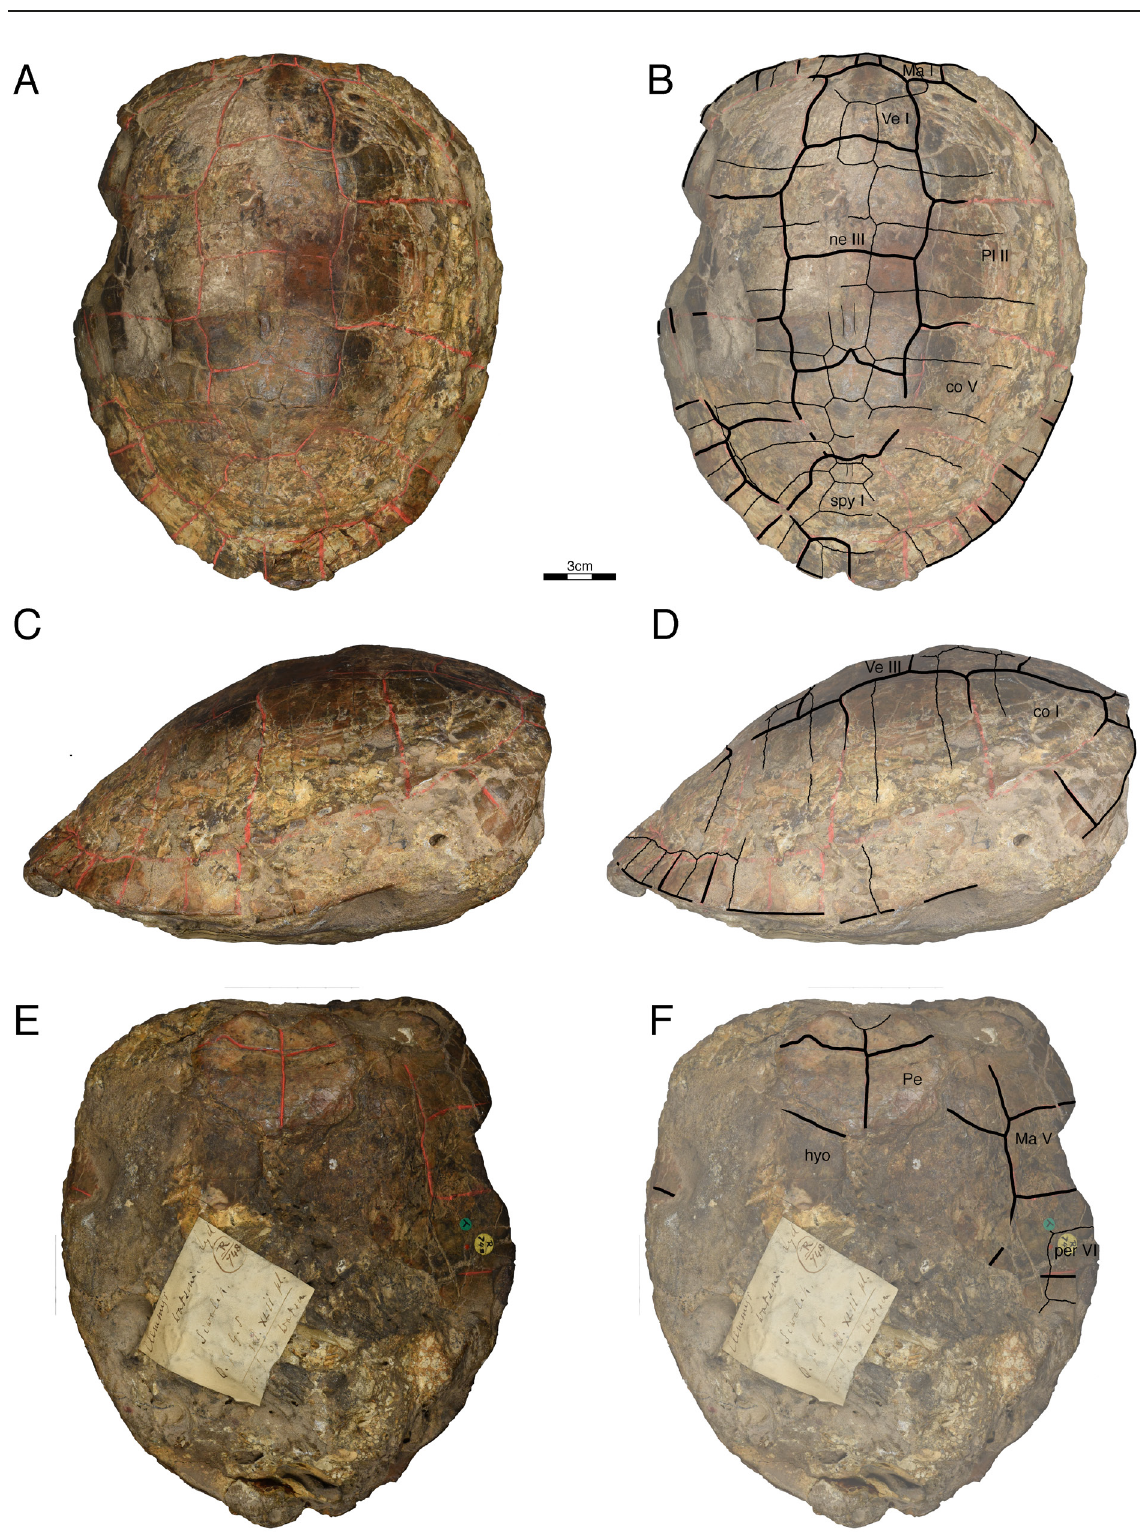
Fig. 20. BMNH R.748, holotype of Clemmys watsoni Lydekker, 1886a, here identified as synonym of Hardella thurjii (Gray, 1831). A . Photograph of carapace. B . Illustration of carapace. C . Photograph of carapace in lateral view. D . Illustration of carapace in lateral view. E . Photograph of plastron. F . Illustration of plastron. Scale bar: